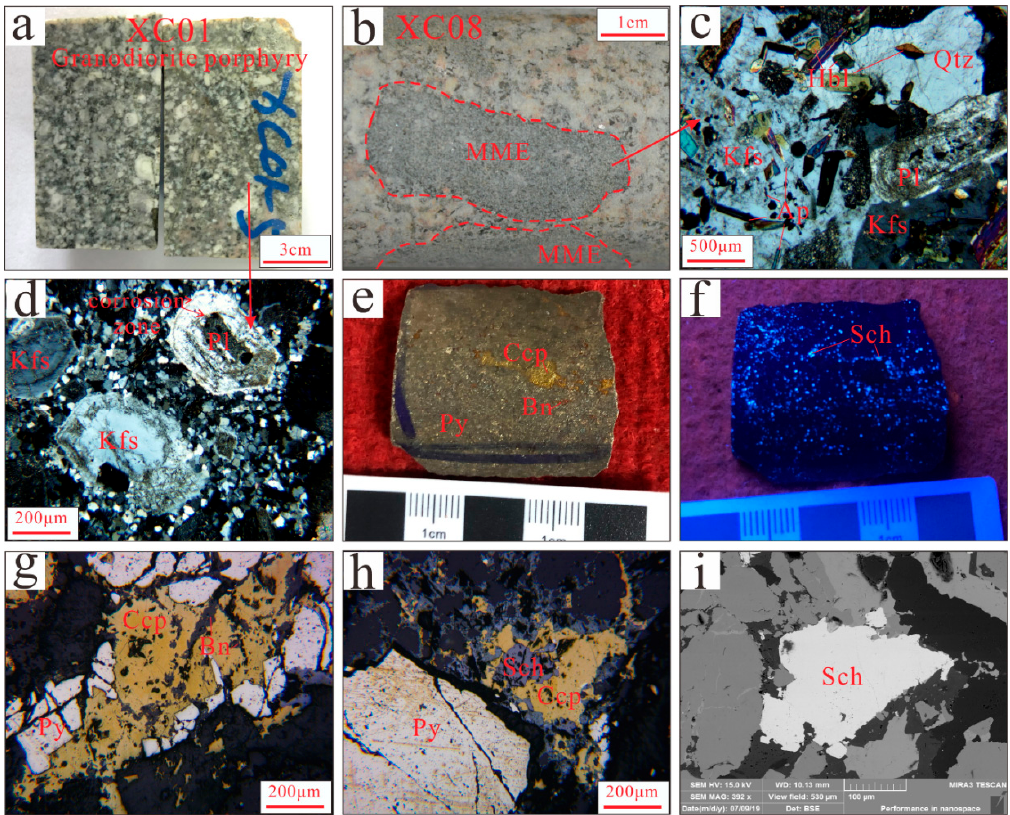
Figure 3. Photographs and photomicrographs of the Qiaomaishan Cu–W deposits. ( a ) Granodiorite porphyry; ( b ) granodiorite porphyry with mafic microgranular enclaves (MMEs); photomicrographs of the ( c ) MMEs and ( d ) granodiorite porphyry; ( e ) copper tungsten ores; ( f ) scheelite in the ores under a UV lamp; ( g , h ) chalcopyrite, pyrite, and scheelite in the sulfide ores under reflected light; ( i